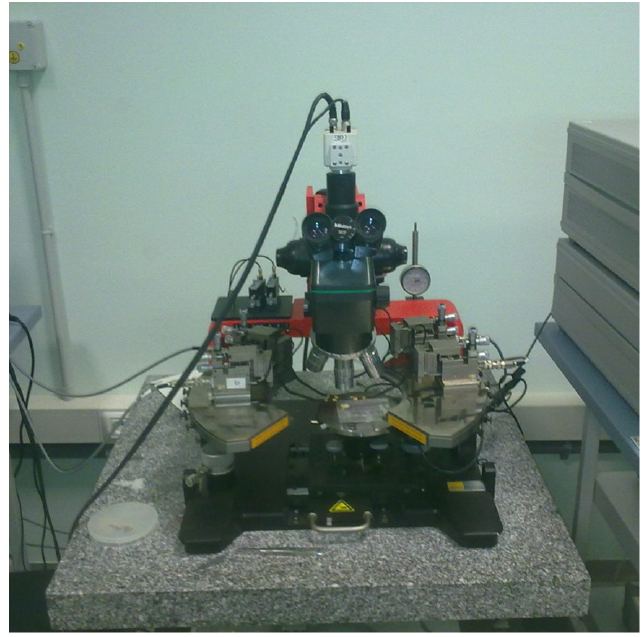
Figure 8. PM5 Karl Suss MicroTec.